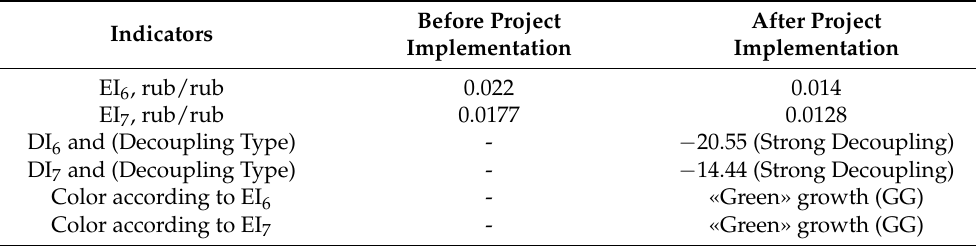
Table 11. Resource decoupling indicators of the project and the “color” of the project. Before Project Indicators